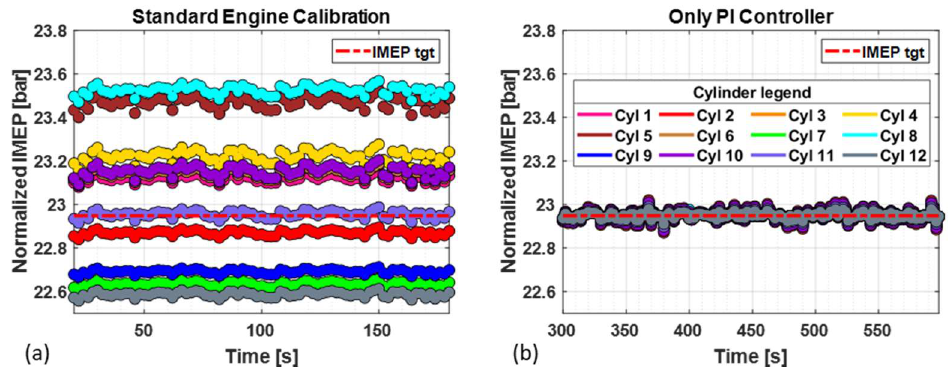
Figure 12. Comparison between the desired IMEP target and the actual value of IMEP produced by all the 12 cylinders at 1800 rpm and 100% pedal: ( a ) when the ECU is using only the open loop control, ( b ) when the PI control of SOC and TOC are active.